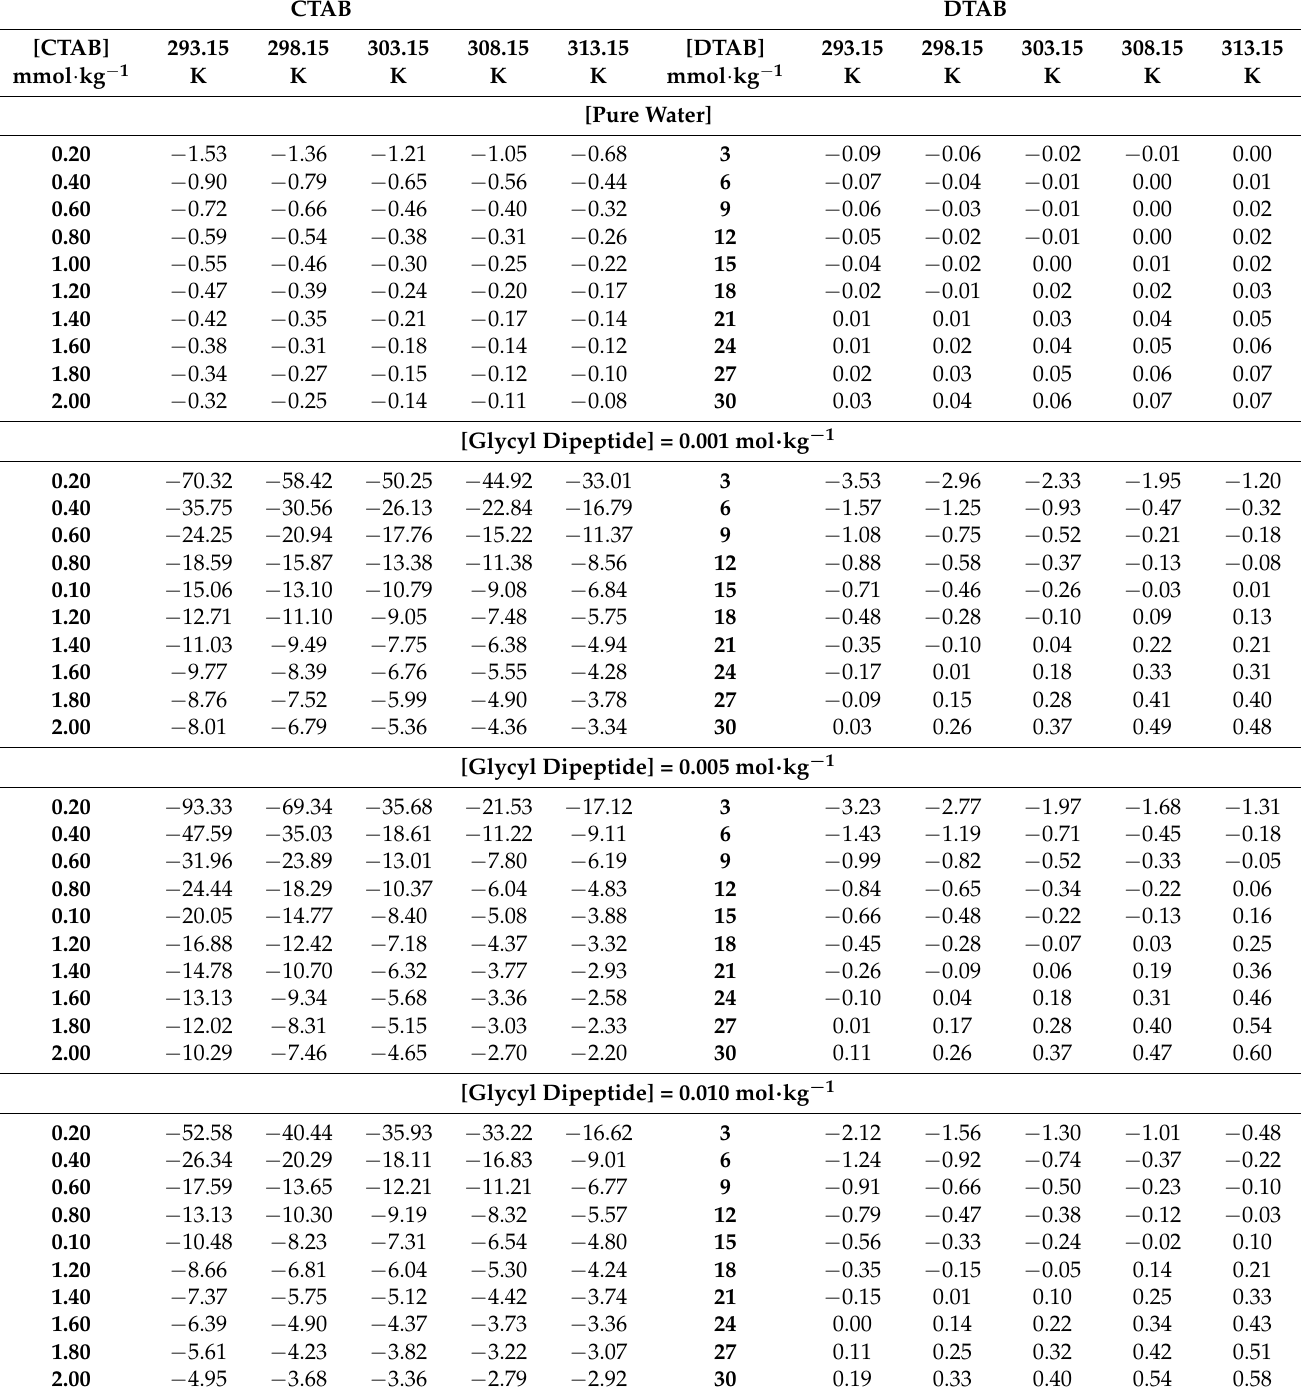
Table 4. Apparent molar isentropic compression, κ s , ϕ /10 − 3 (m 3 · mol − 1 · Pa − 1 ) values for